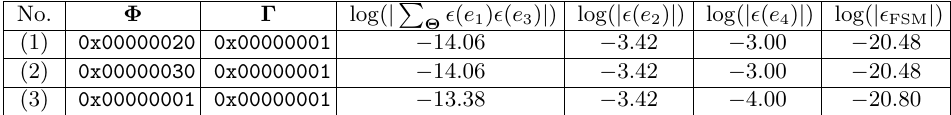
Table 3: The best bitwise masks ( Φ , Γ ) for linear approximation (3) when Λ = 0x1014190f No.